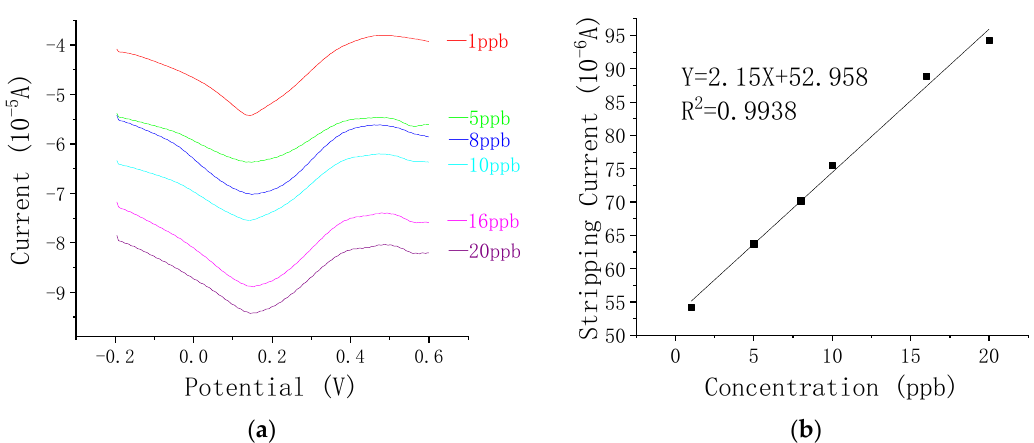
Figure 8. ( a ) SWV response of Fe 3 O 4 –rGO/GCE towards As(III) under pH 3 phosphate buffer, − 0.4 V deposition potential, and 8 µ L drop volume; ( b ) relation between the peak current and As(III) concentration under pH 3 phosphate buffer, − 0.4 V deposition potential, and 8 µ L drop volume. Table 1. Comparative study on the performance of different electrochemical sensors for As(III) detection.